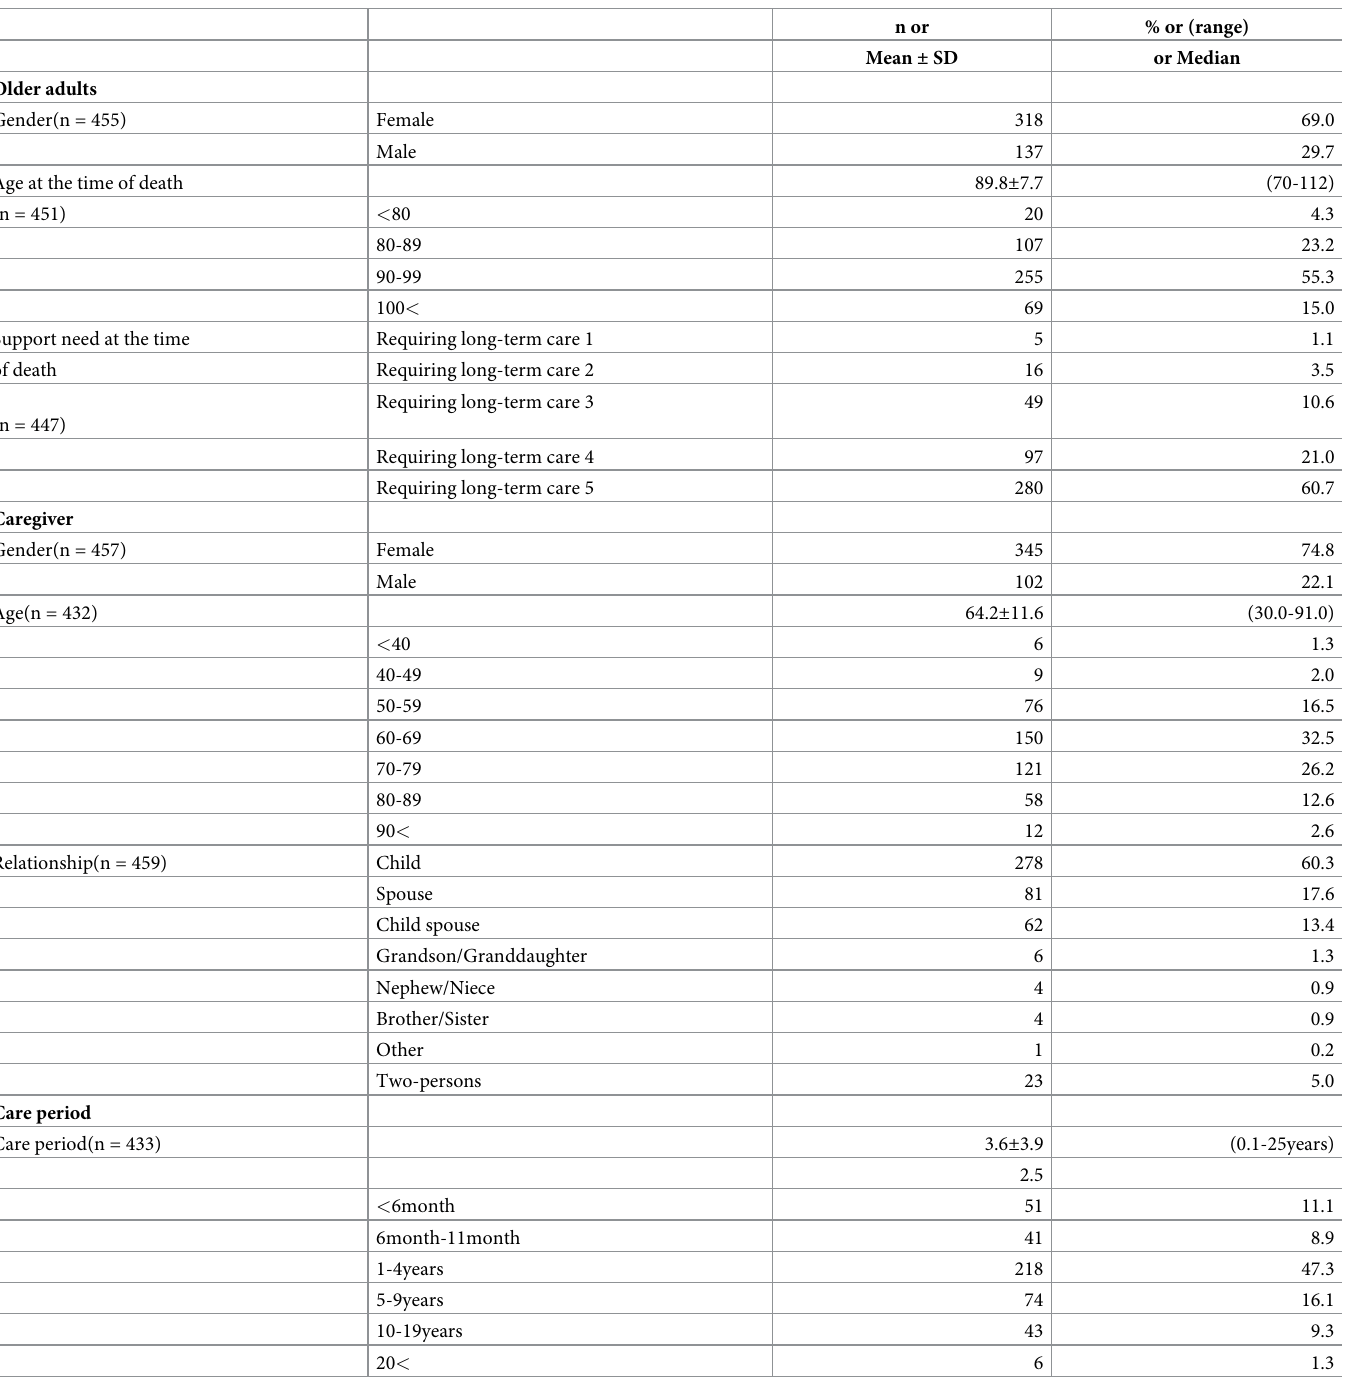
Table 2. Summary of the end-of-life care case of senility at